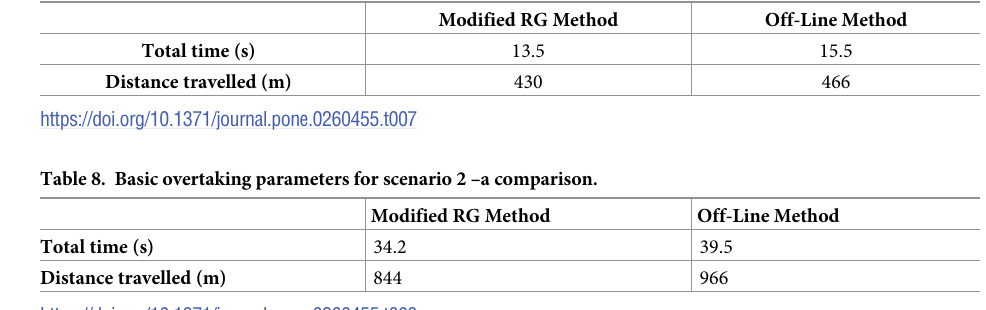
Table 7. Basic overtaking parameters for scenario 1 –a comparison.